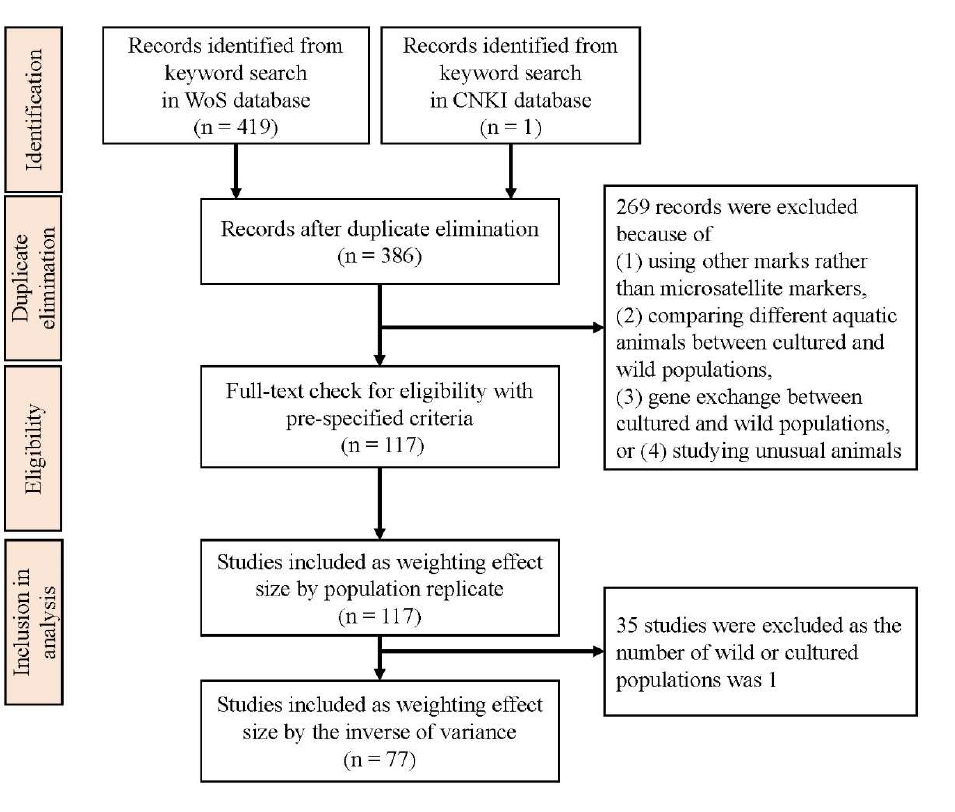
Figure 2. Selection of literature to be included in the meta-analysis data set.